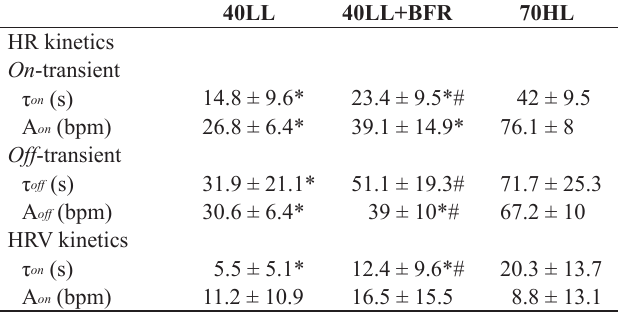
Table 2. Mean and SD of heart rate on - and off -transient kinetics and heart rate variability on -transient kinetics during the constant load aerobic exercise for each experimental